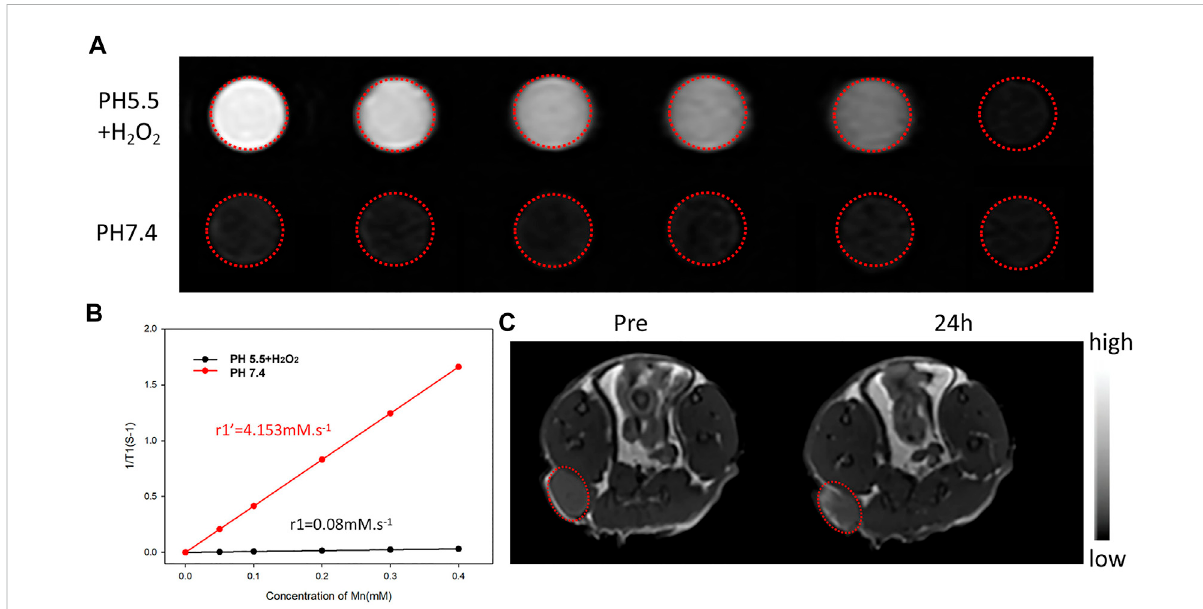
FIGURE 7 (A) T1-weighted MR images of IR780/PLGA@MnO 2 NPs suspensions at different Mn concentrations and pH values with H 2 O 2 . (B) The longitudinal(r1)relaxationrate vs.